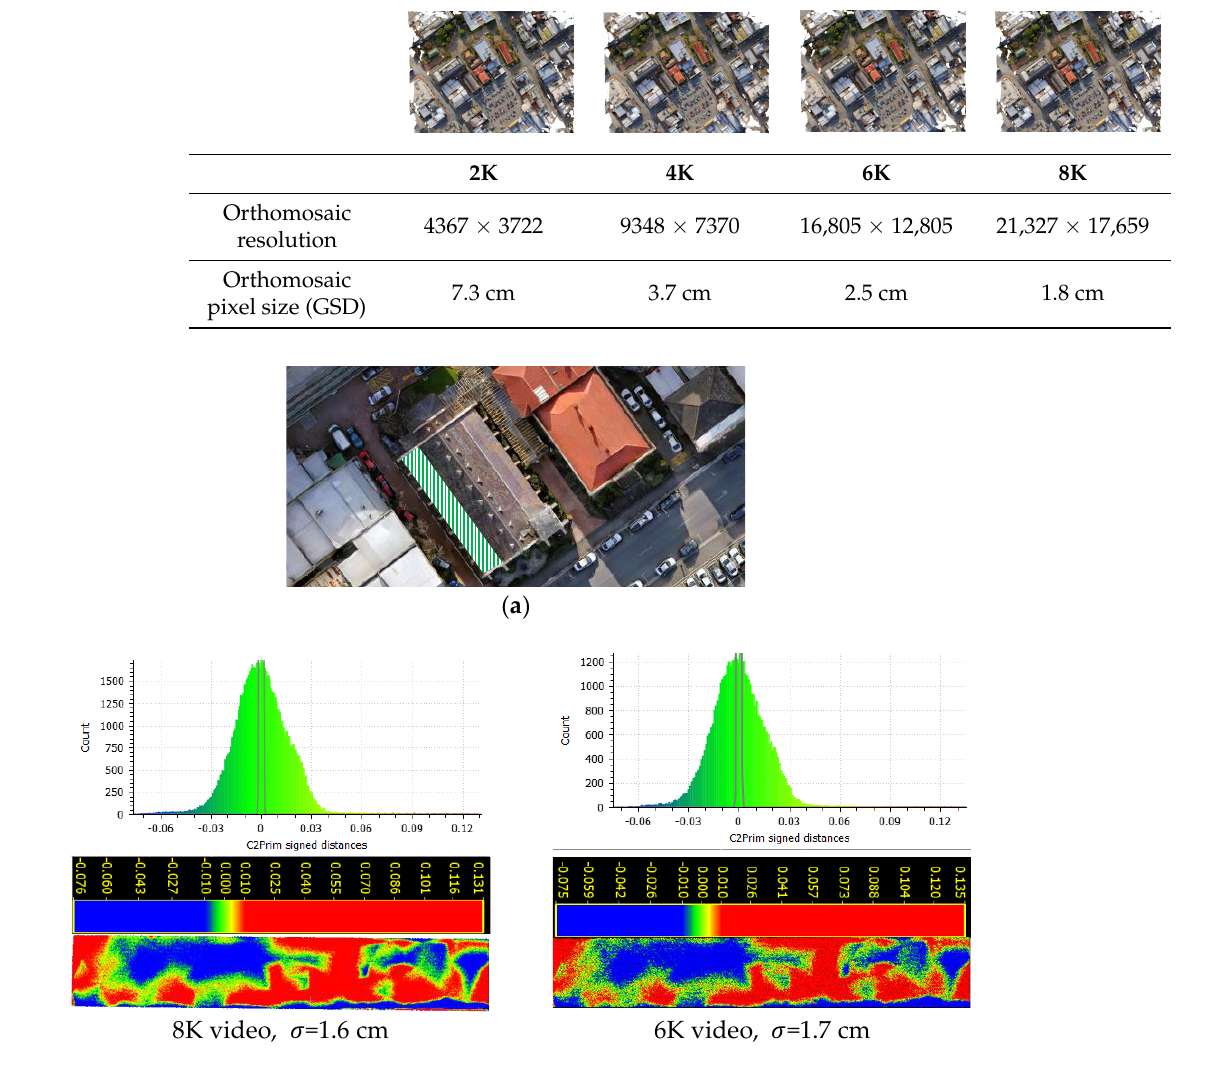
Table 1. Orthomosaic resolution and pixel size of the first experiment.